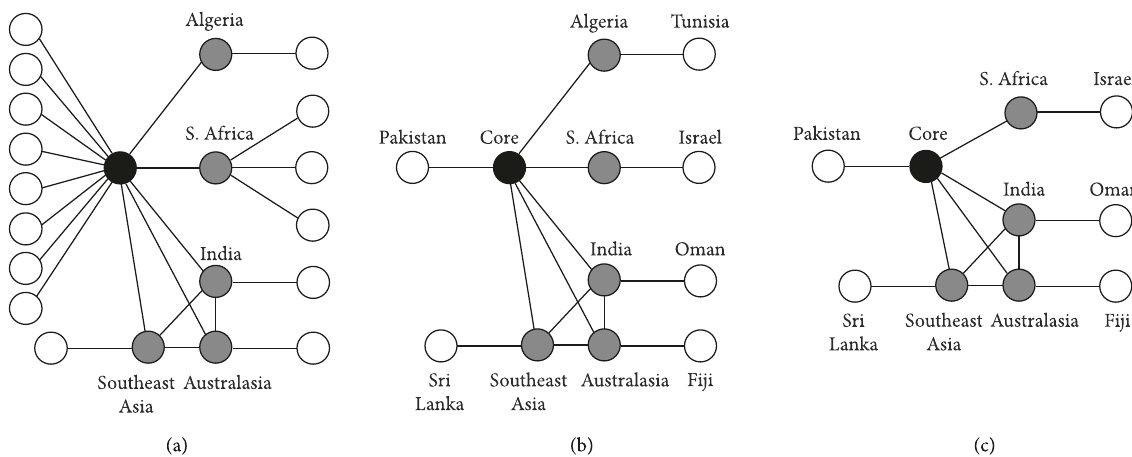
Figure 7: Adding a dissimilarity measure: (a) CSP network; (b) reduction of false twin vertices; (c) CSP